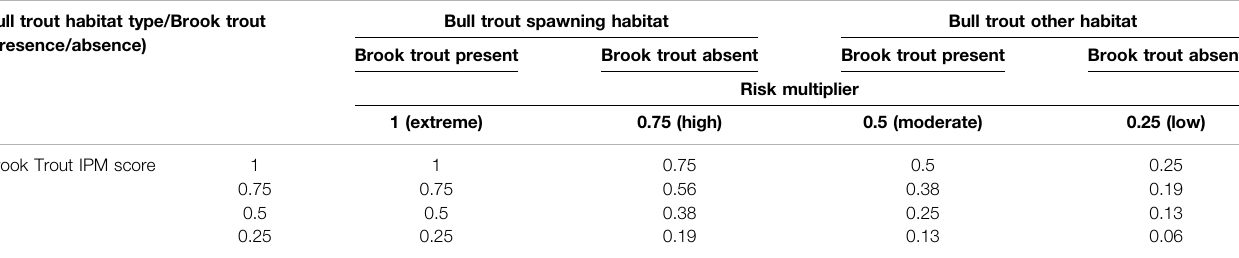
TABLE 1 | Criteria to establish hybridization risk scores as a function of brook trout spawning IPM score, brook trout presence/absence, and bull trout habitat use type. Bull trout habitat type/Brook trout